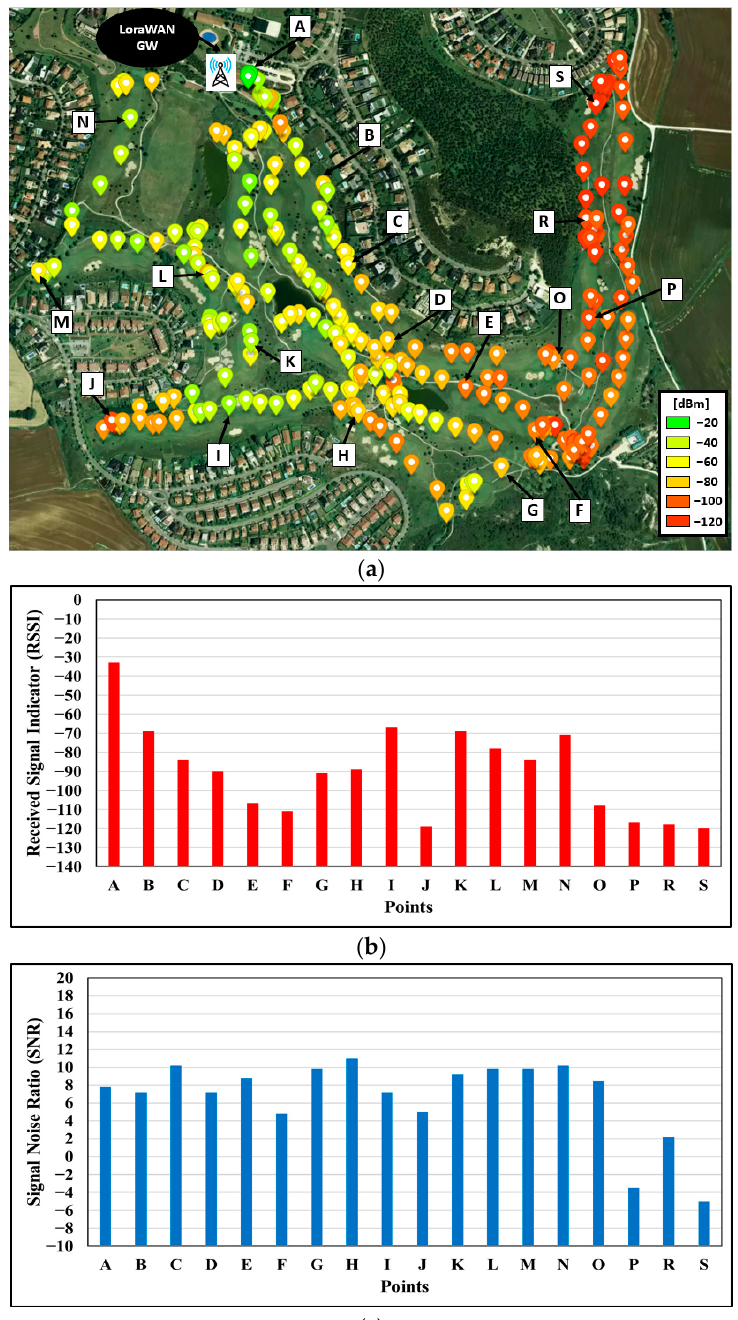
Figure 13. ( a ) Location of devices when packets are received by the LoRa WAN Gateway, with the corresponding RSSI level; ( b ) Detail of the RSSI level for the points corresponding to the points labeled in Figure 13a; ( c ) Detail of the SNR for the points corresponding to the points labeled in Figure 13a.